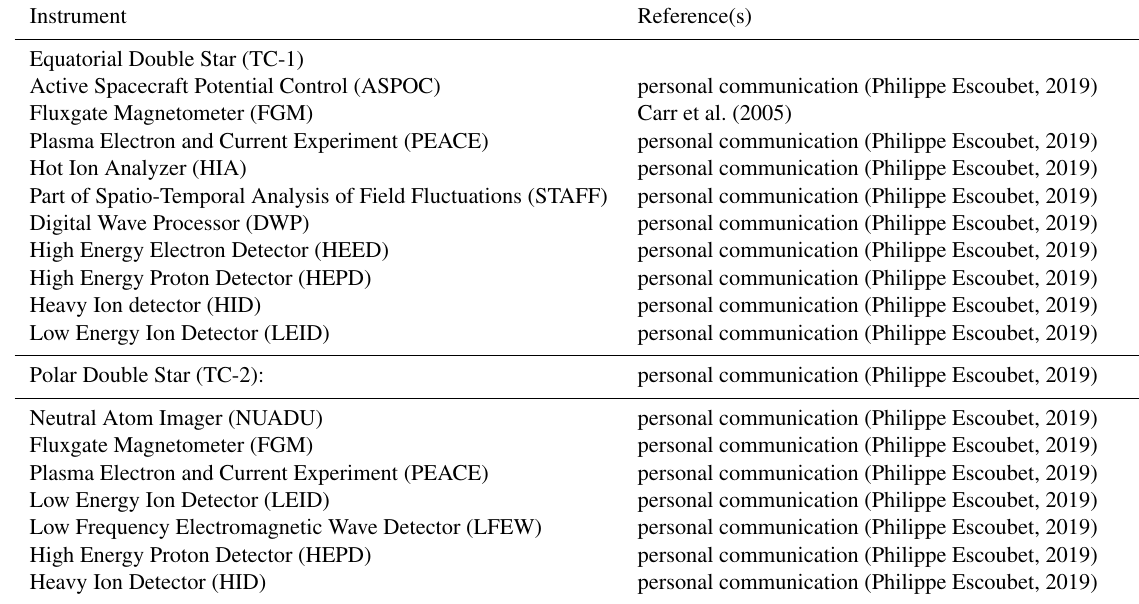
Table A8. Double Star’s instruments and references for team members lists.